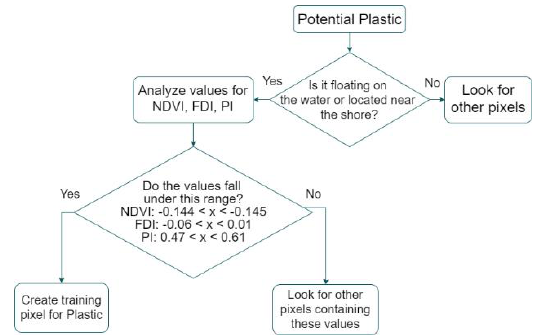
Figure 2 . Decision tree for selecting training data for the Plastic class.